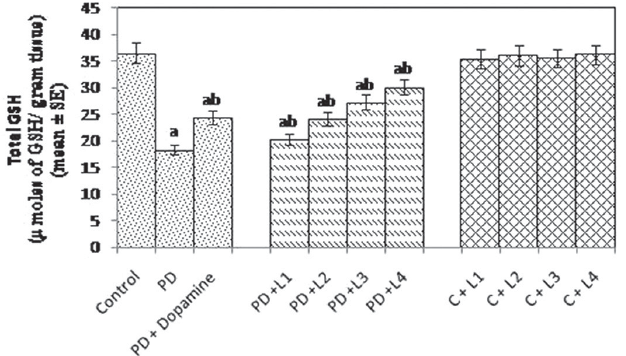
FIGURE 2 - Effect of luteolin on the glutathione (GSH) content in the brains of flies. [L1= 25 µM; L2= 50 µM; L3 = 75 µM; L4= 100 µM; PD = PD flies; Dopamine=10-3 M]. The flies were allowed to feed on the diet supplemented with luteolin for 24 days and then assayed for GSH content. The values are the mean of 5 assays. [a - significant at p<0.05 compared to control; b - significant at p<0.05 compared to PD flies].